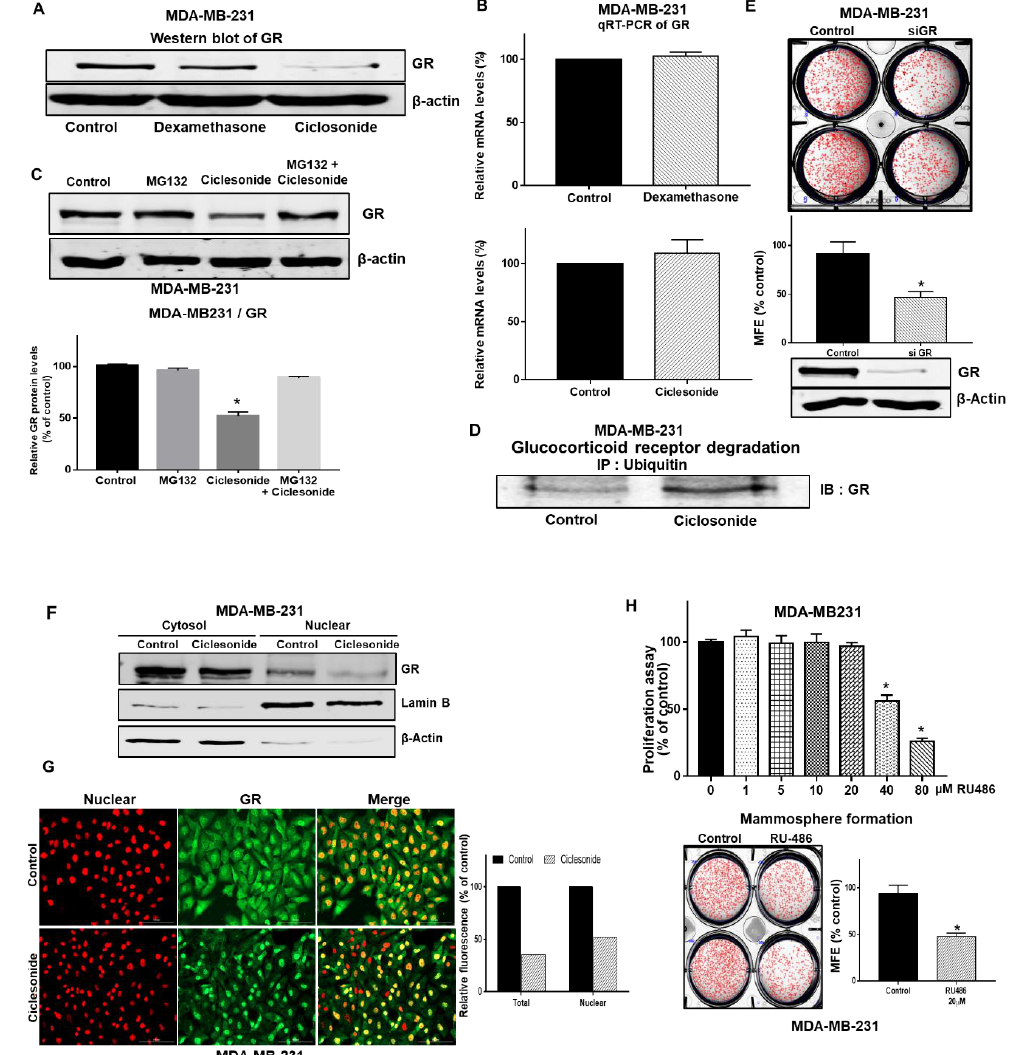
Figure 4. Ciclesonide blocks glucocorticoid receptor (GR) signaling pathway activation through the downregulation of GR. ( A ) Mammospheres were cultured for 5 days and incubated with ciclesonide for two days. After treatment with ciclesonide (10 μM), the expression level of GR was measured with an anti-GR antibody. Ciclesonide treatment decreased GR expression in MDA-MB-231-derived mammospheres. ( B ) After treatment with ciclesonide and dexamethasone, the transcription level of GR was assessed by real-time RT-qPCR using specific primers. We used β-actin as the internal control. ( C ) Mammospheres were cultured with MG-132 and ciclesonide for one day and lysed for immunoblot using an anti-GR antibody and β-actin as the internal control. Data from triplicate experiments are presented as the means ± SDs; * p < 0.05 vs. the control. Experiments were repeated three times. ( D ) Mammospheres were incubated with ciclesonide (10 μM) for 24 h and lysed for immunoprecipitation with an anti-ubiquitin antibody and immunoblot analysis with an anti-GR antibody. ( E ) The e ff ect